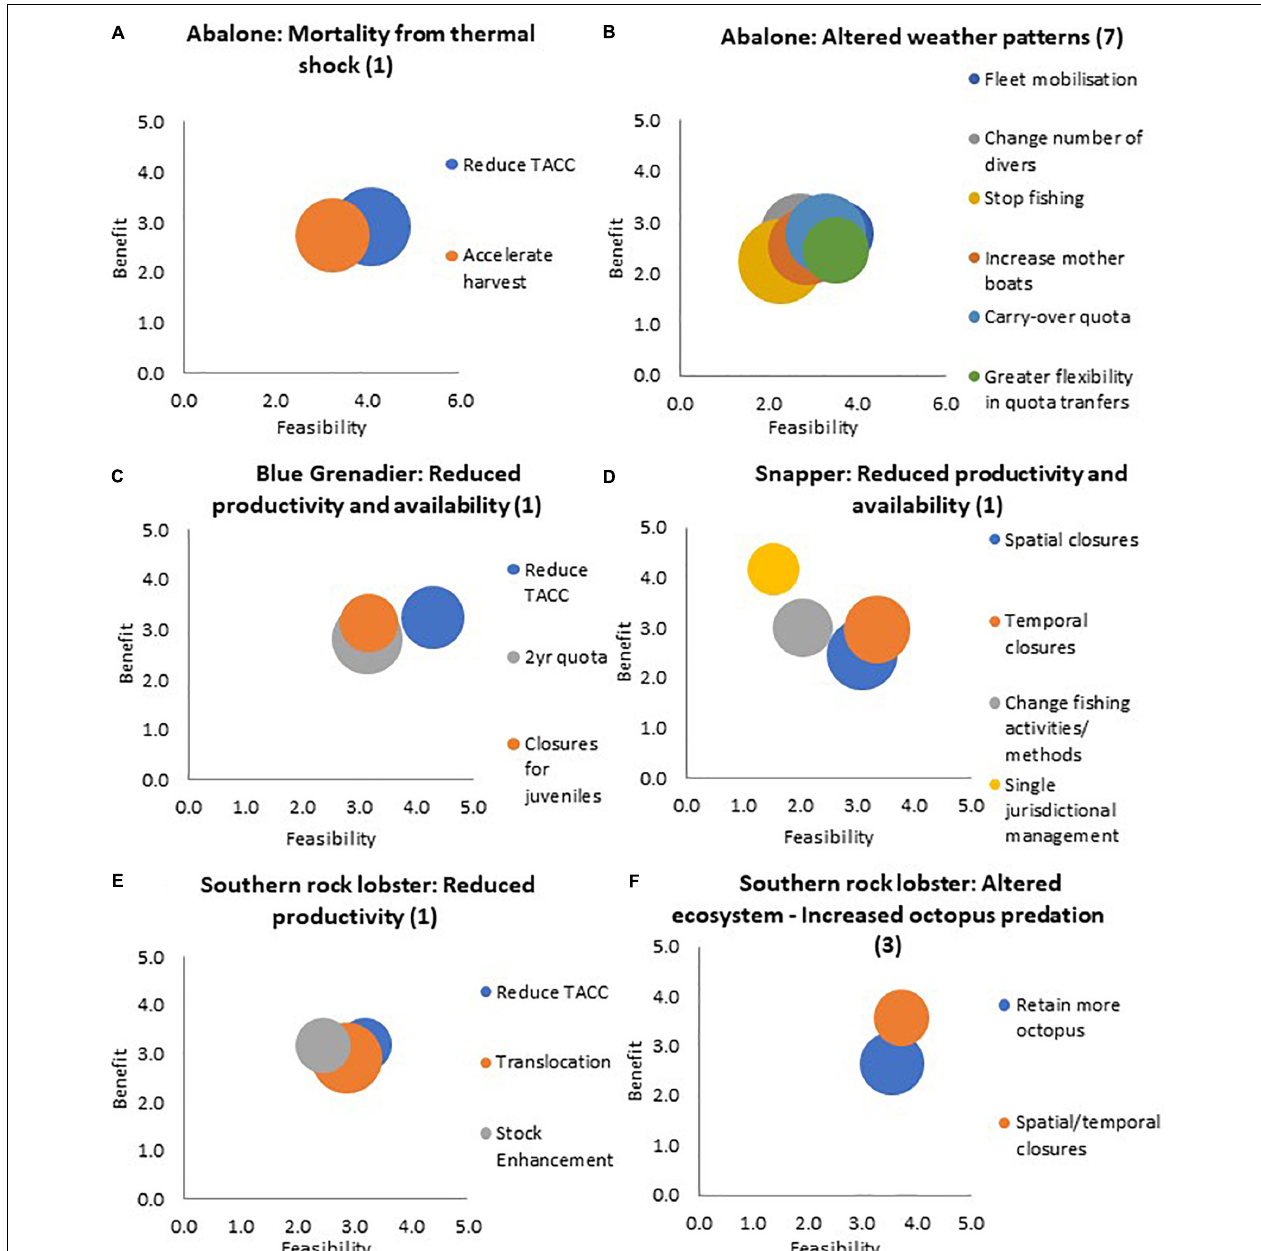
FIGURE 3 | Evaluation scores for level of expected benefit, feasibility, and risk of selected adaptation options addressing specific climate challenges for abalone (A,B) , blue grenadier (C) , snapper (D) , and southern rock lobster fisheries (E,F) in south-eastern Australia. The size of the bubble reflects the level of risk. The number in brackets refers to the broad challenge from the respective